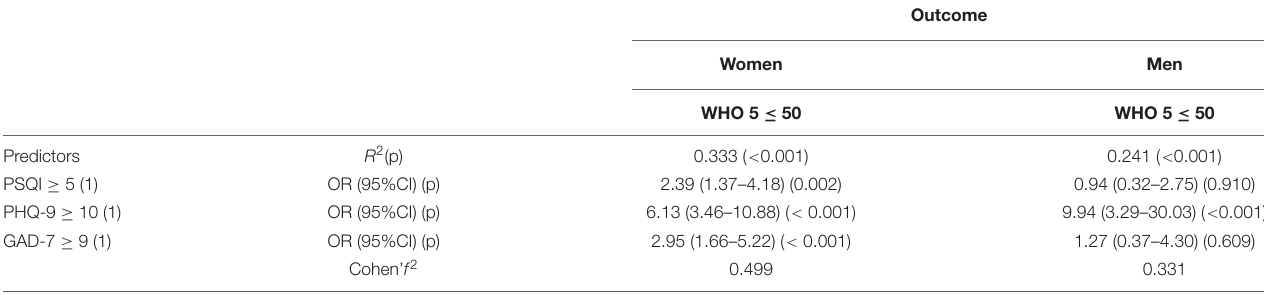
TABLE 2 | Multivariable logistic regression analyses for women and